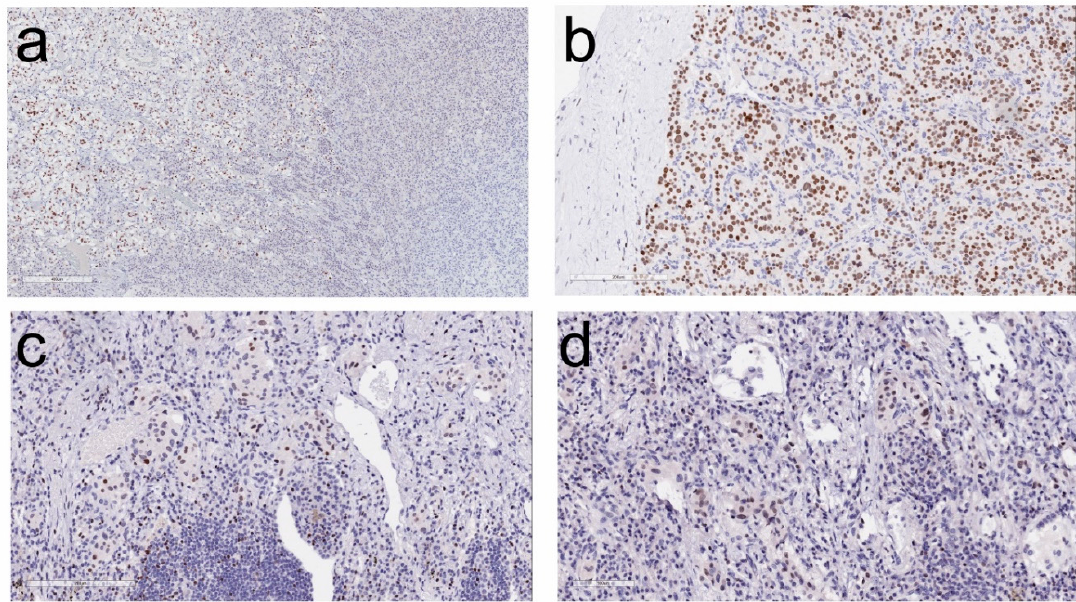
Figure 4. GATA-3 (GATA-binding factor 3) immunolocalization in adrenal medulla and paragangliomas. ( a ) In this section of normal adrenal, the medulla (left) stains for GATA-3 whereas the adrenal cortex (right) is completely negative. ( b ) A cardiac paraganglioma exhibits strong nuclear reactivity for GATA-3. ( c , d ) Lung paragangliomas have variable nuclear positivity for GATA-3.